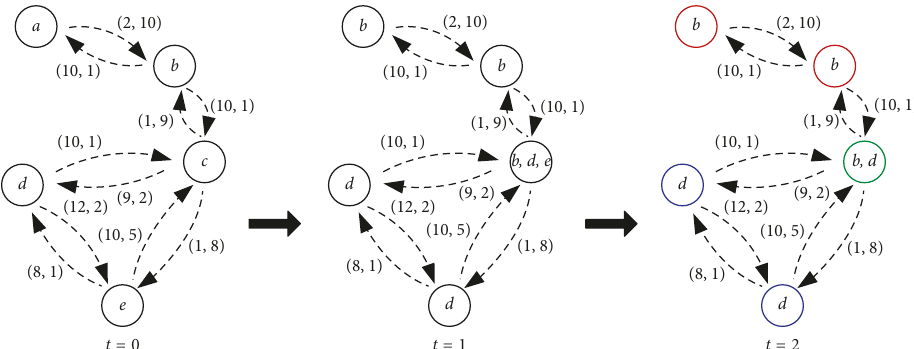
Figure 5: A simple simulation of the SLP process. The numbers in parentheses represent the number of normal and infected com- munications in turn.